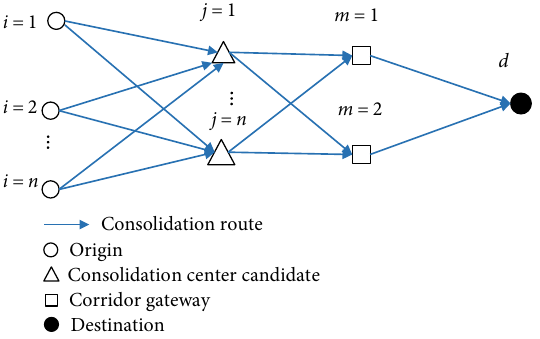
Figure 4: Flows of cargo in the CRECN. Abbreviations: origin; = consolidation center; 𝑗